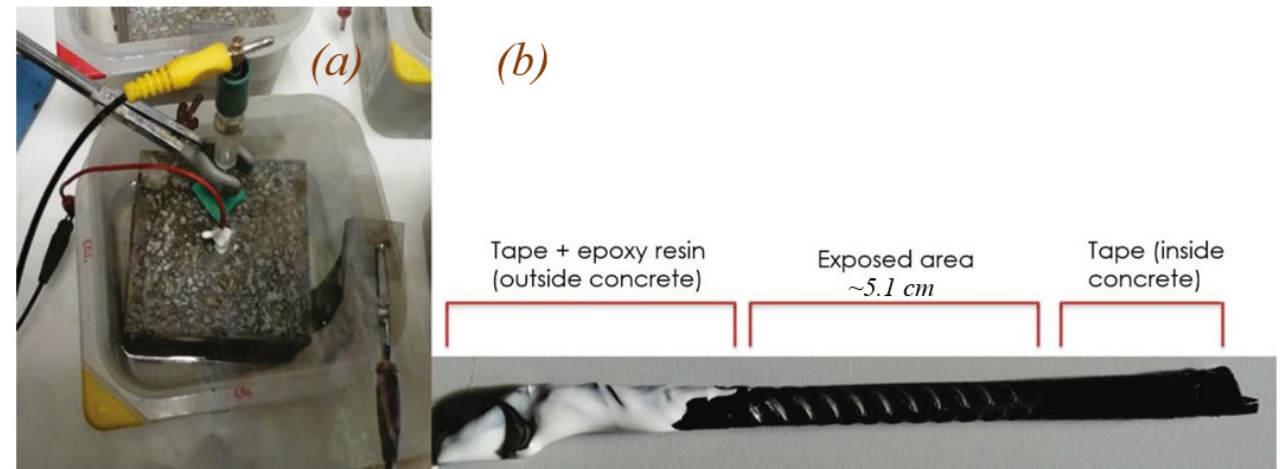
Figure 1. ( a ) Experimental setup; ( b ) detail of bar prepared for testing and area to be exposed to concrete when embedded.